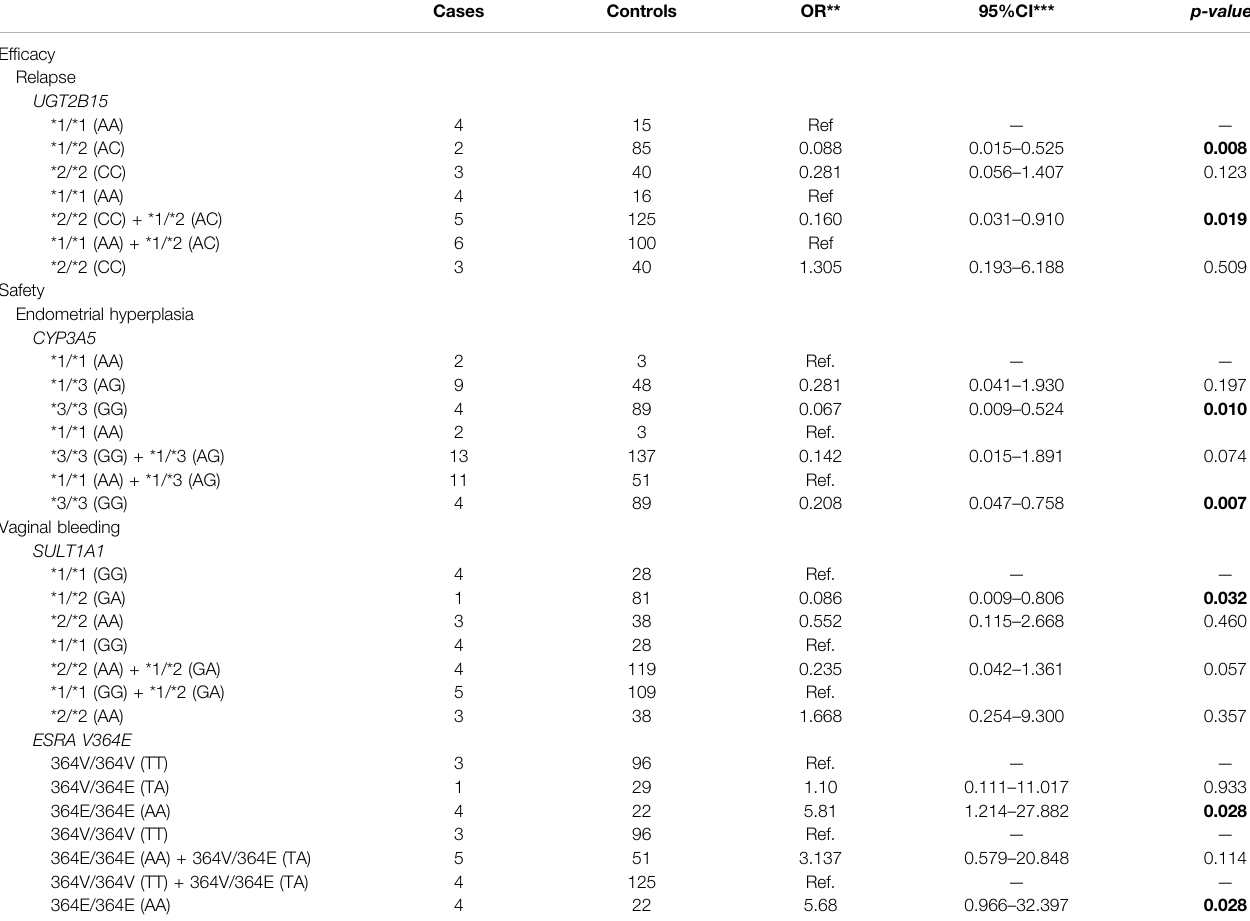
TABLE 4 | Univariable logistic regression analysis of risk of severe ADRs according to genotypes.